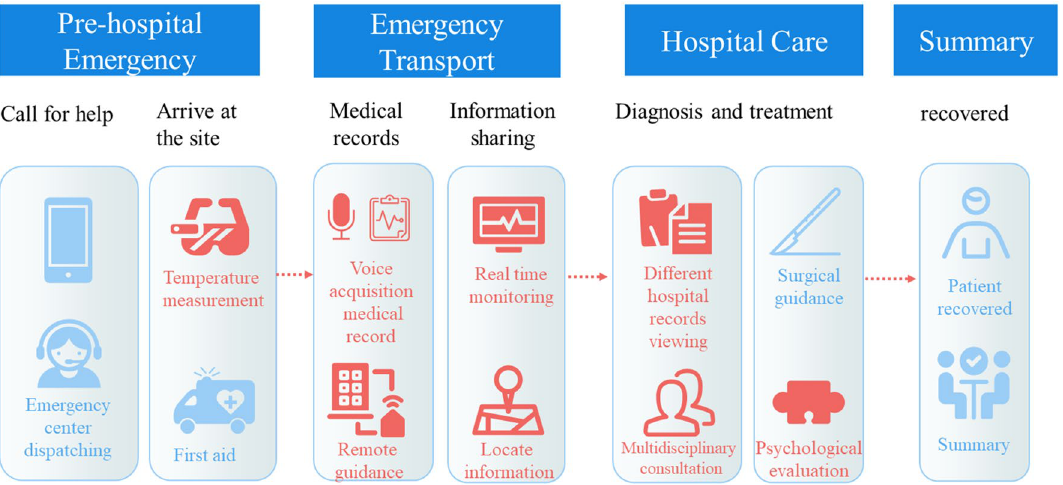
Figure 2. The emergency treatment flow chart (the red part is new in this study, and the blue part is the general emergency flow).